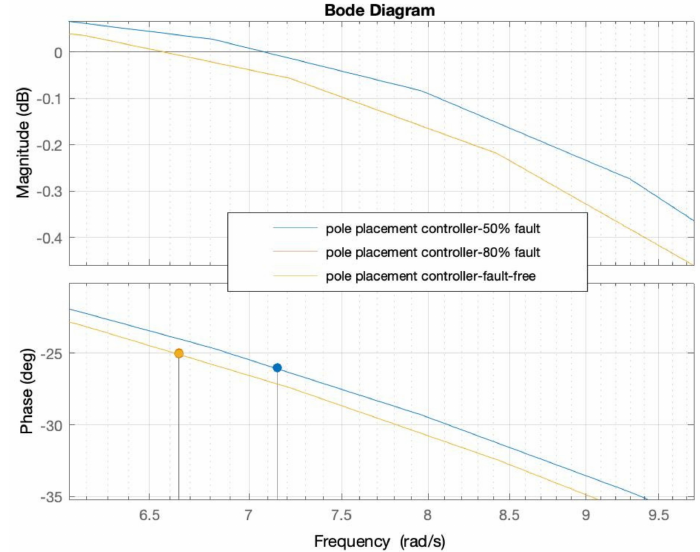
Figure 8. Closed-loop Bode plots of pole placement.